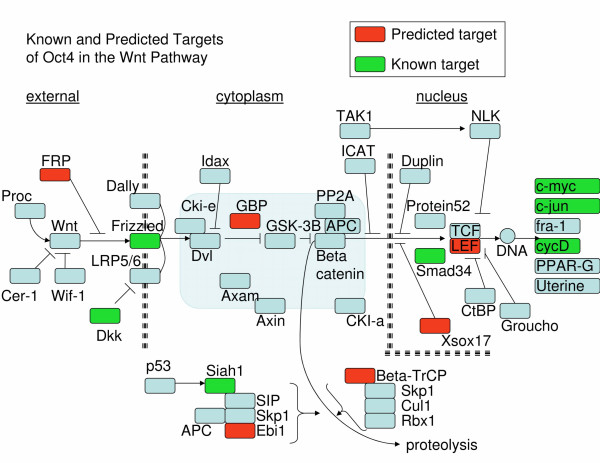
Oct-4 Targets in the Wnt Signalling Pathway. Known targets of Oct-4 are filled in green and new predictions are filled in red. Known targets and predicted targets are statistically enriched for genes falling in this pathway.